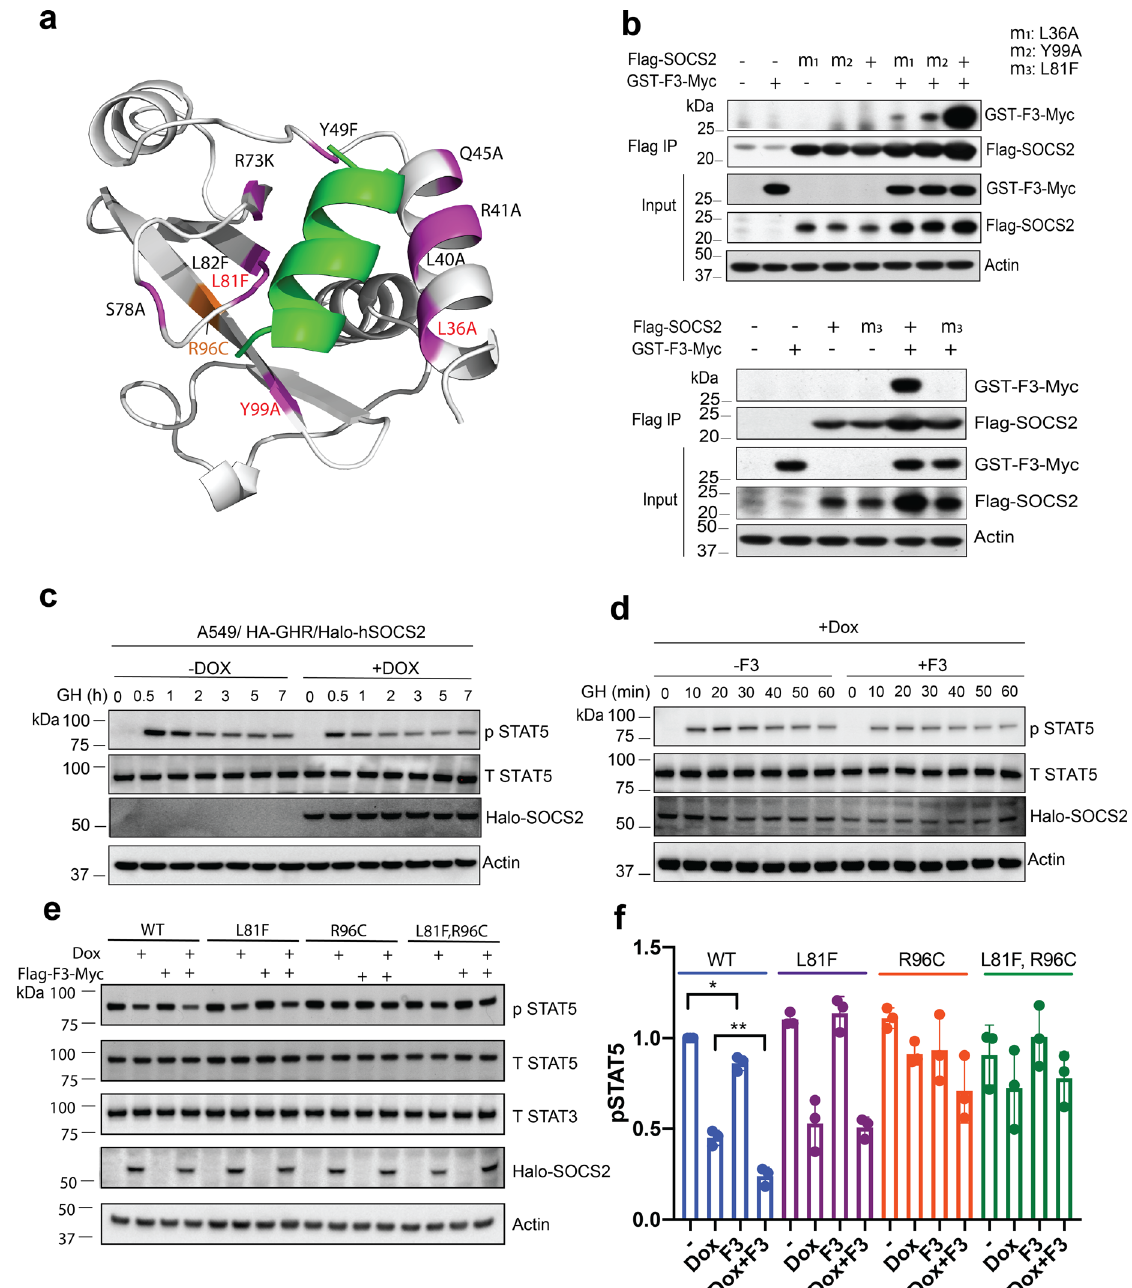
Fig. 5 F3 binding stabilizes SOCS2 and enhances SOCS2 inhibition of GH signaling. a F3-bound SOCS2 crystal structure highlighting residues in magenta that were mutated and tested by SPR. Red labels indicate mutations that disrupted F3 binding. Related to Table 2. b 293T cells were transfected with constructs for wild-type Flag-SOCS2 or SOCS2 with key F3-contacting residues mutated, with and without GST-F3-Myc expression. Cells were treated with GH and lysed prior to immunoprecipitation of SOCS2 and immunoblotting with anti-Myc antibodies. All three mutations signi fi cantly reduced SOCS2 interaction with F3, with SOCS2-L81F resulting in complete loss of F3 interaction. m1: SOCS2-L36A; m2: SOCS2-Y99A, m3: SOCS2-L81F; IP immunoprecipitation. Representative of two independent experiments. c A549 cells with stable expression of HA-GHR (A549-GHR) were treated overnight with doxycycline (dox) to induce Halo-SOCS2 expression and then stimulated with 50 ng/mL GH for up to 7 h, prior to lysis and analysis by immunoblotting with antibodies to the indicated proteins. Representative of four independent experiments. d A549-GHR cells were transfected with Flag- F3-Myc constructs and then treated overnight with doxycycline (dox) to induce Halo-SOCS2 expression. Cells were then treated with 50 ng/mL GH for 0, 10, 20, 30, 40, 50, 60 min, lysed, and analyzed by immunoblotting with antibodies to the indicated proteins. p phosphorylated; T total (F3). Representative of two independent experiments. e A549-GHR cells were transfected with Flag-F3-Myc constructs (F3) prior to overnight dox treatment to induce wild- type (WT) or mutant Halo-SOCS2 proteins. Cells were then treated with 50 ng/mL GH for 30 min, lysed, and analyzed by immunoblotting with antibodies to the indicated proteins. p phosphorylated; T total. Representative of three independent experiments. f Densitometric analysis of pSTAT5 bands relative to WT (no dox, no F3); derived from three independent experiments including data shown in e and in Supplementary Fig. 8. Data shown are mean ± S.D. and were analyzed using a paired t test. * p = 0.025, ** p = 0.0052. Source data are provided as a Source Data fi